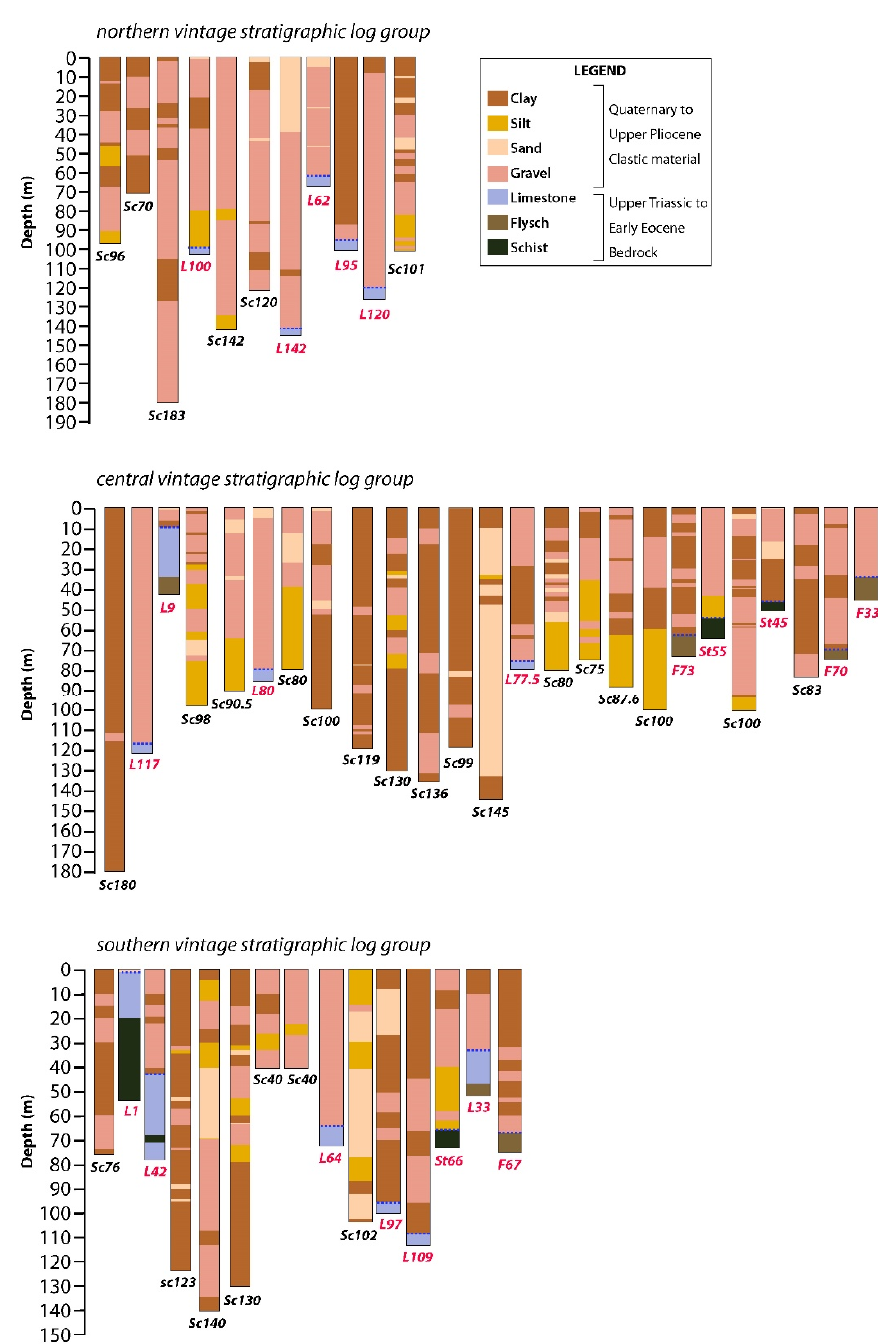
Figure 3. Simplified vintage stratigraphic logs in the Argive Basin, Peloponnese, Greece (compiled by Hinojosa-Prieto [30] after GSLI, unpublished data, and Karastathis et al. [23,24]). A complex interbedding of different clastic textures are observed in the stratigraphic logs, suggesting